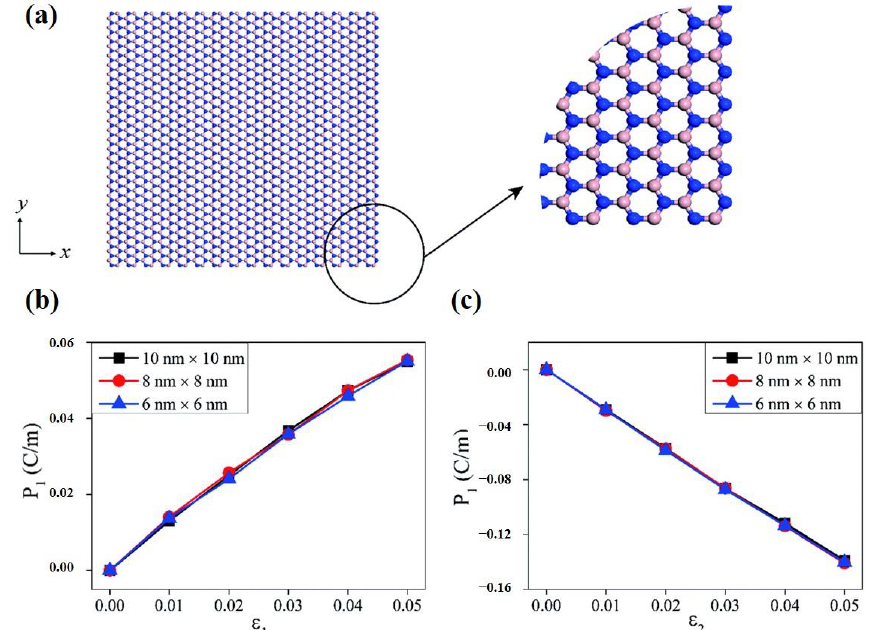
Figure 9. ( a ) The atomic structure of rectangular shaped boron nitride nanosheets. The amplified area shows armchair and zigzag boundaries along the x and y directions, respectively [101]. Reprinted with permission from [101]. Copyright 2018 Royal Society of Chemistry. ( b ) The polarization changes of different size boron nitride nanosheets when strained along the armchair direction and ( c ) zigzag direction [101]. Reprinted with permission from [101]. Copyright 2018 Royal Society of Chemistry.